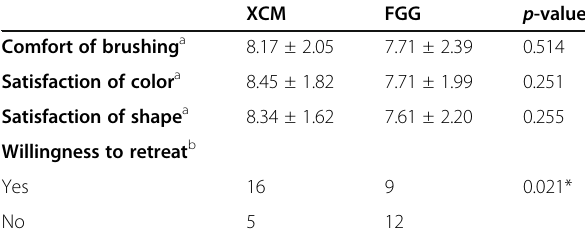
Table 5 PROMs after 6-month follow-up XCM FGG p -value Comfort of brushing a